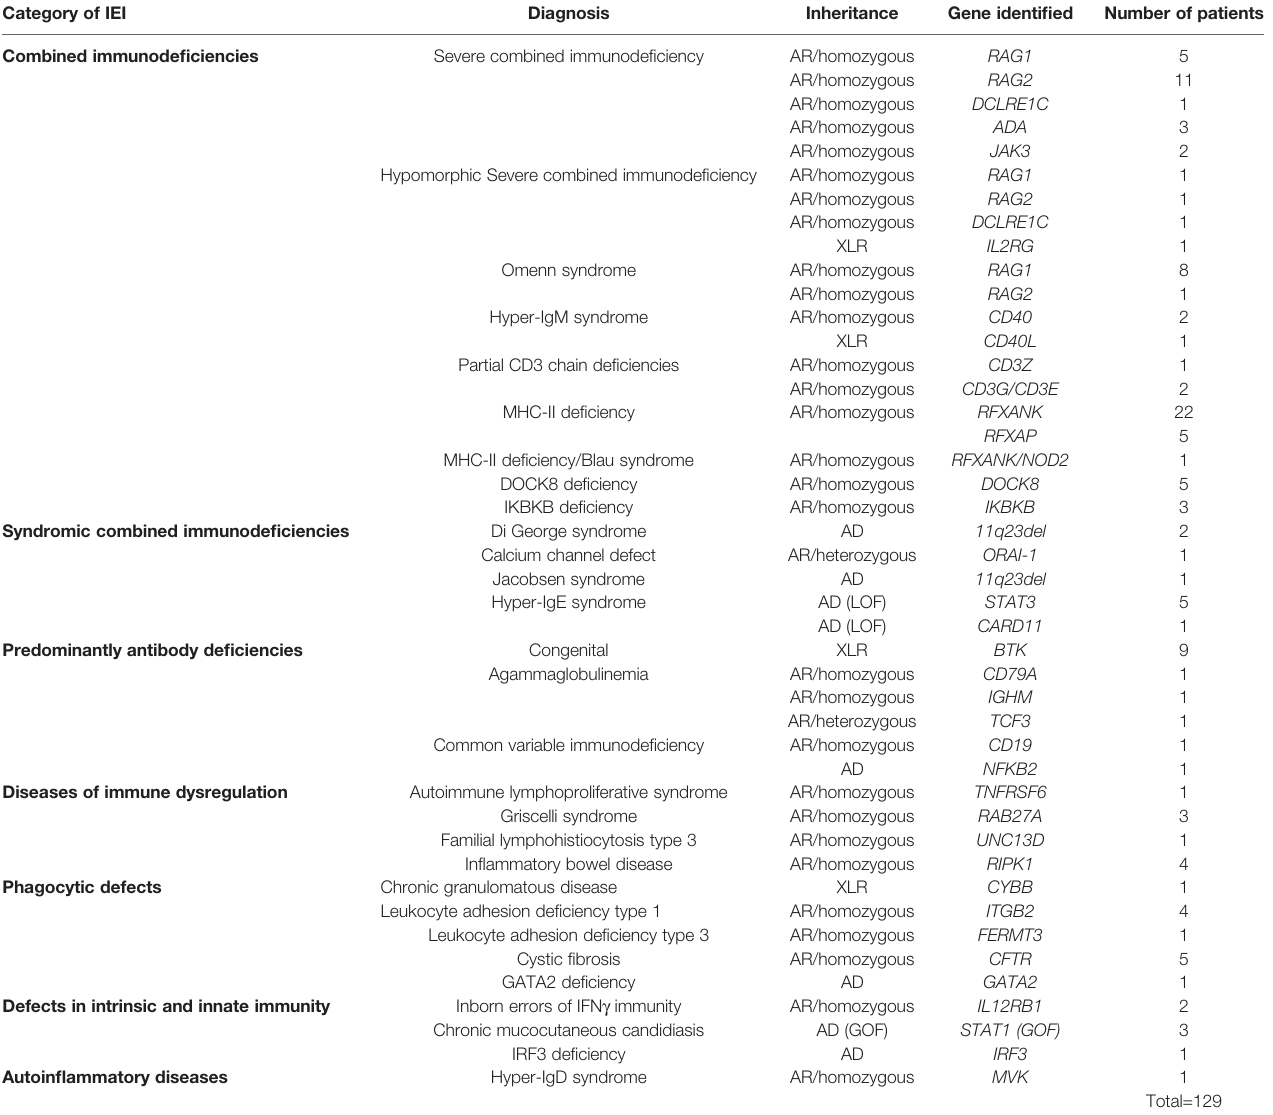
TABLE 3 | distribution of patients according to genetically-con fi rmed